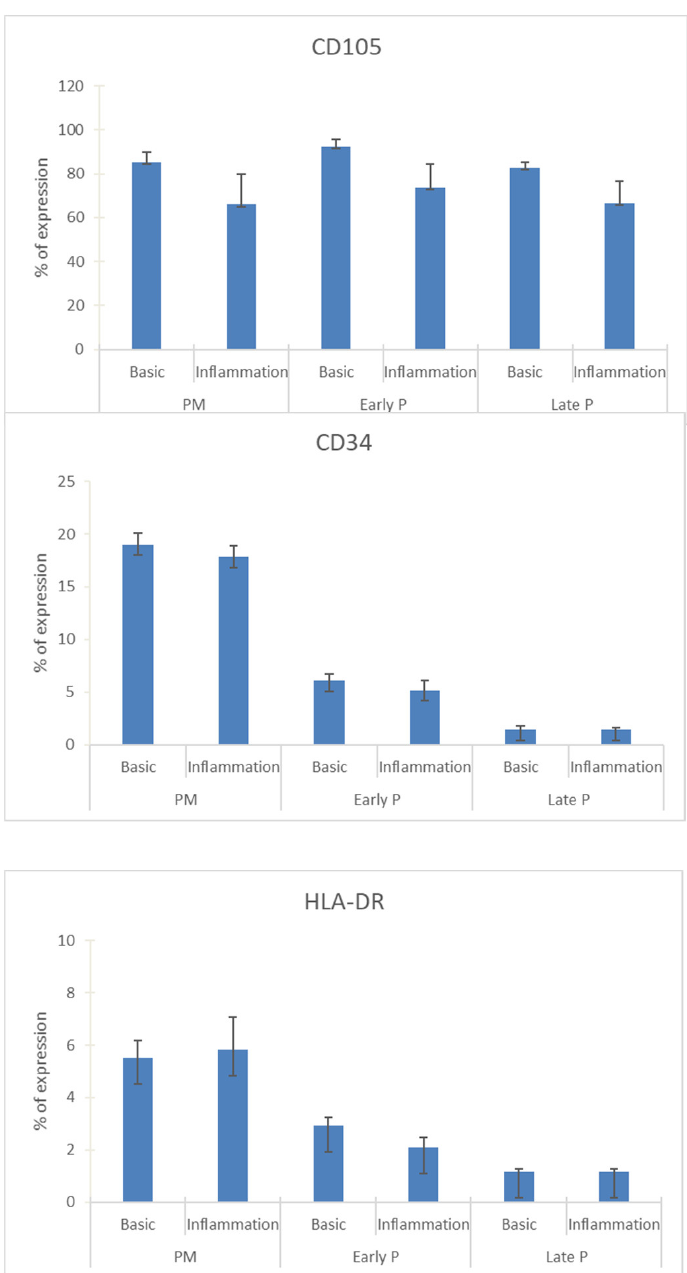
Figure 2. The expression profile of CD34, CD105 and HLA-Dr during cell expansion of MSCs. These markers were analyzed by flow cytometry. The results are presented in the graphic as the mean ± SEM percentage of each marker expression. Representative FACS histograms are also shown for basic (black curve) and inflammation conditions (red curve) during PM, early and late passage cultures. The grey curve represents the antibody control.